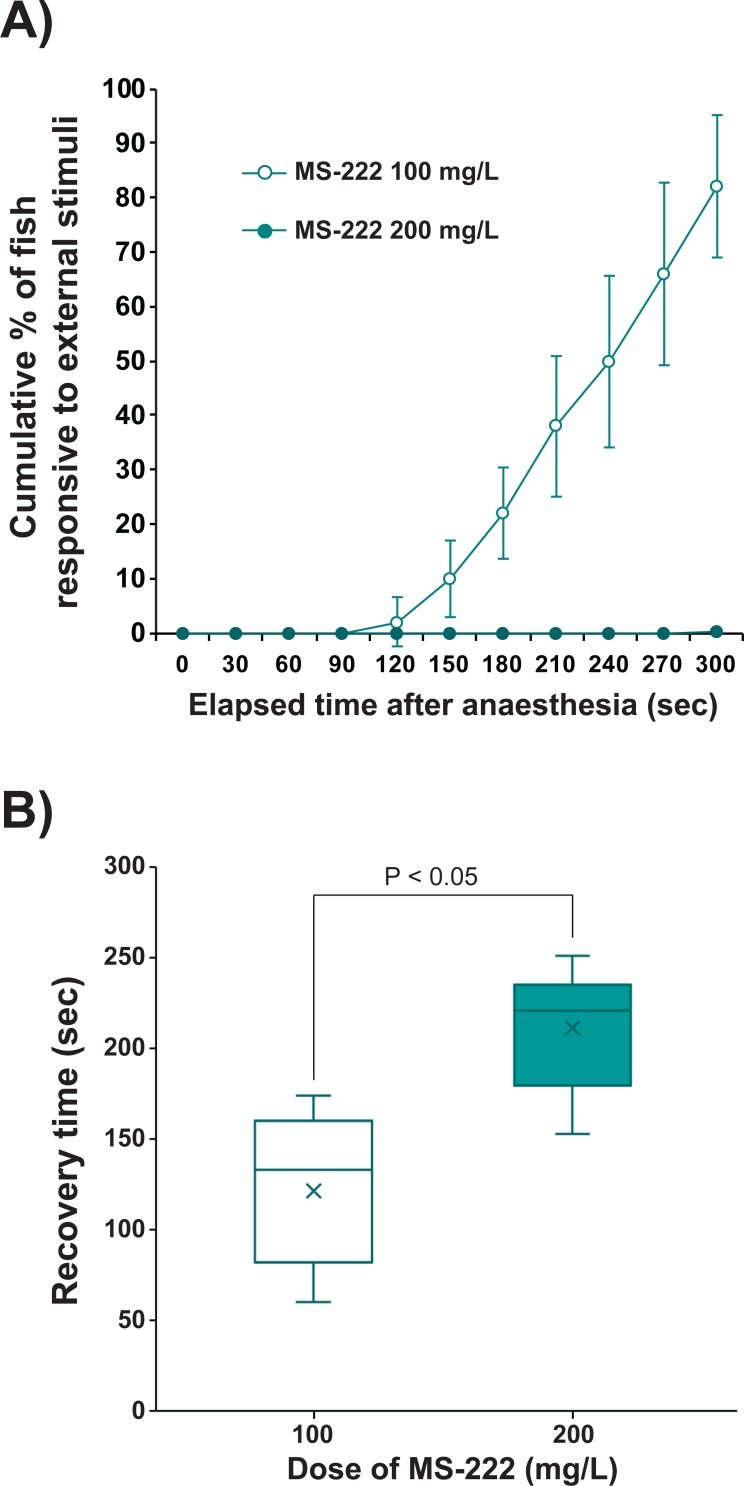
Reflex activity against external stimuli of prolarvae immersion treated with 100 and 200 mg/L of MS-222.Fish were anesthetized with 100 mg/L or 200 mg/L of MS-222, then exposed to air for 5 min. During air exposure, fish (N = 10 per replicate examination for either dose) were stimulated externally by gentle pressing with a glass needle. Five replicate examinations were made. (A) Cumulative percentage of fish showing response to external stimuli. (B) Recovery time after anesthetic treatment followed by 5-min air exposure. In B), lower and upper boundaries of each box indicate the 25th and 75th percentiles, respectively. A line within the box marks the median value. Mean value for each group is noted by the symbol ×. Whiskers above and below the box indicate the 90th and 10th percentiles, respectively. Similar with MS-222, lidocaine (200 mg/L) also displayed stable anesthesia in air without reflex activity against the same external stimuli, however, prolonged recovery time and mortality of a few individuals were observed (S4 Fig).